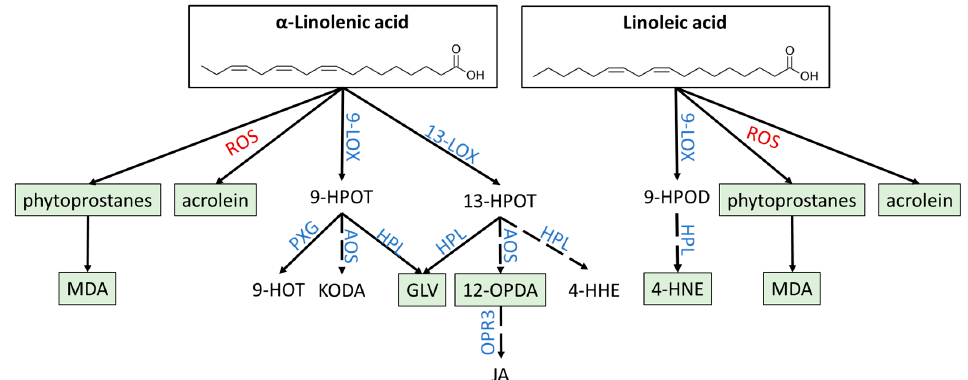
Figure 3. Synthesis pathways of oxylipins. Starting from oxygenation of α -linolenic acid or linoleic acid by LOX or reactive oxygen species, a variety of enzymes generates diverse oxylipins. Most important oxylipins covered in this review are marked in green. Blue: catalyzing enzymes; red: non-enzymatic conversion by ROS; dashed arrows: conversions that occur in multiple steps.